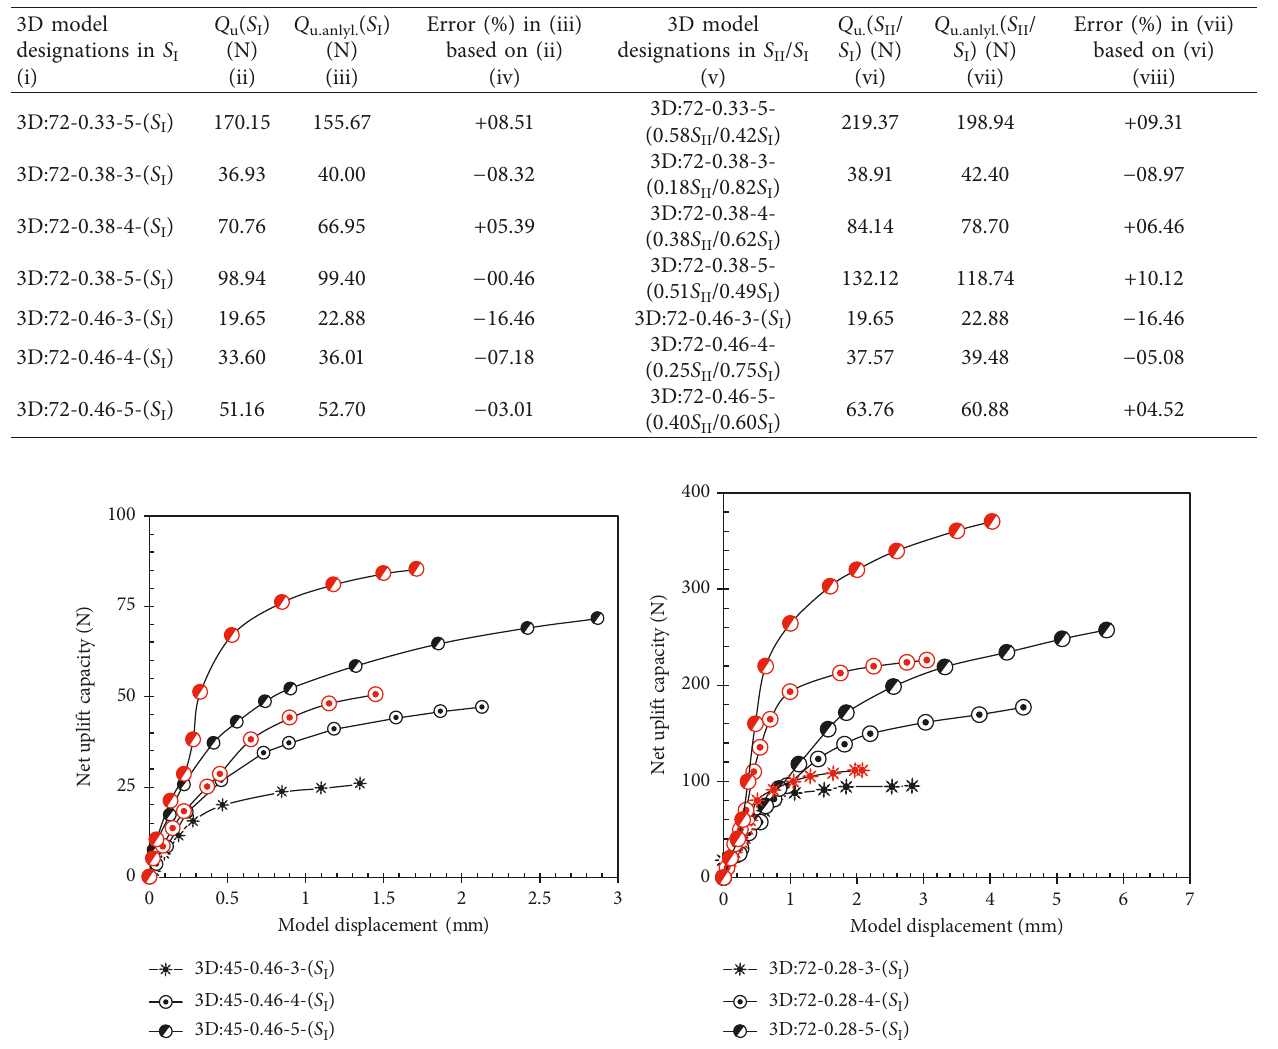
3, 4, and (cid:30) marked along the thickness of each model. This centre line is detectable from outside of plaxi-glass. In this study, applied forces are acting along the vertical plane of 2D panels.